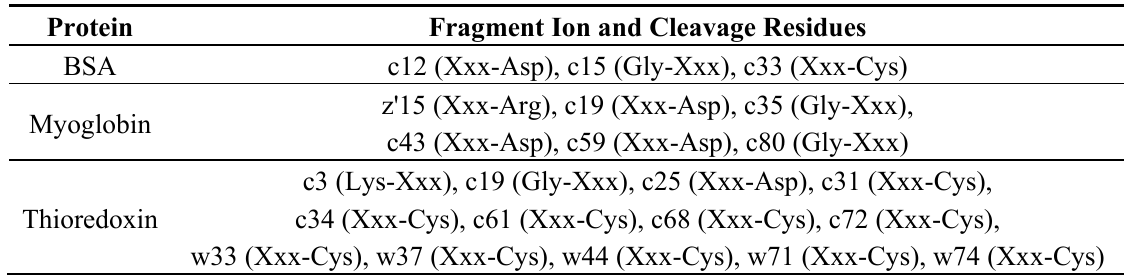
ISD Spectra of Intact Proteins BSA, Myoglobin and Thioredoxin. Protein